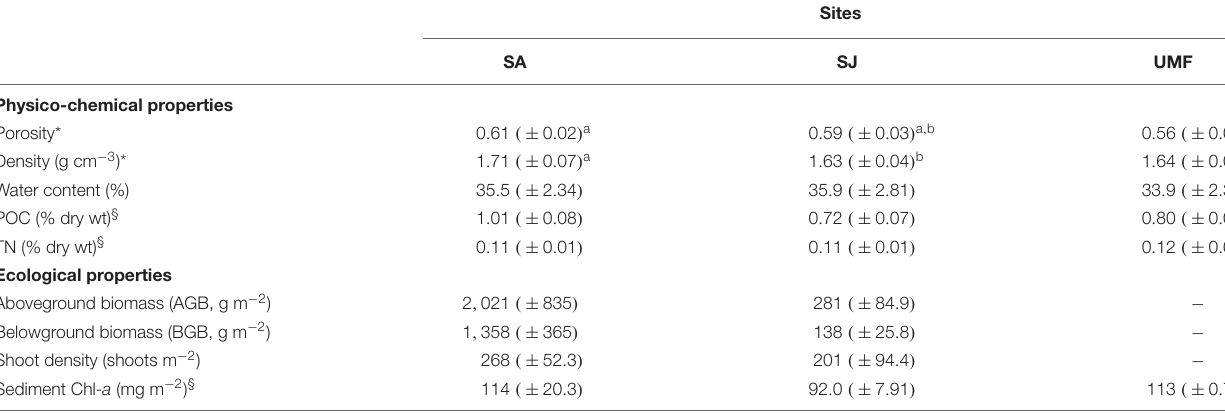
TABLE 1 | Physico-chemical and ecological parameters in the surface sediments (0–10 cm).